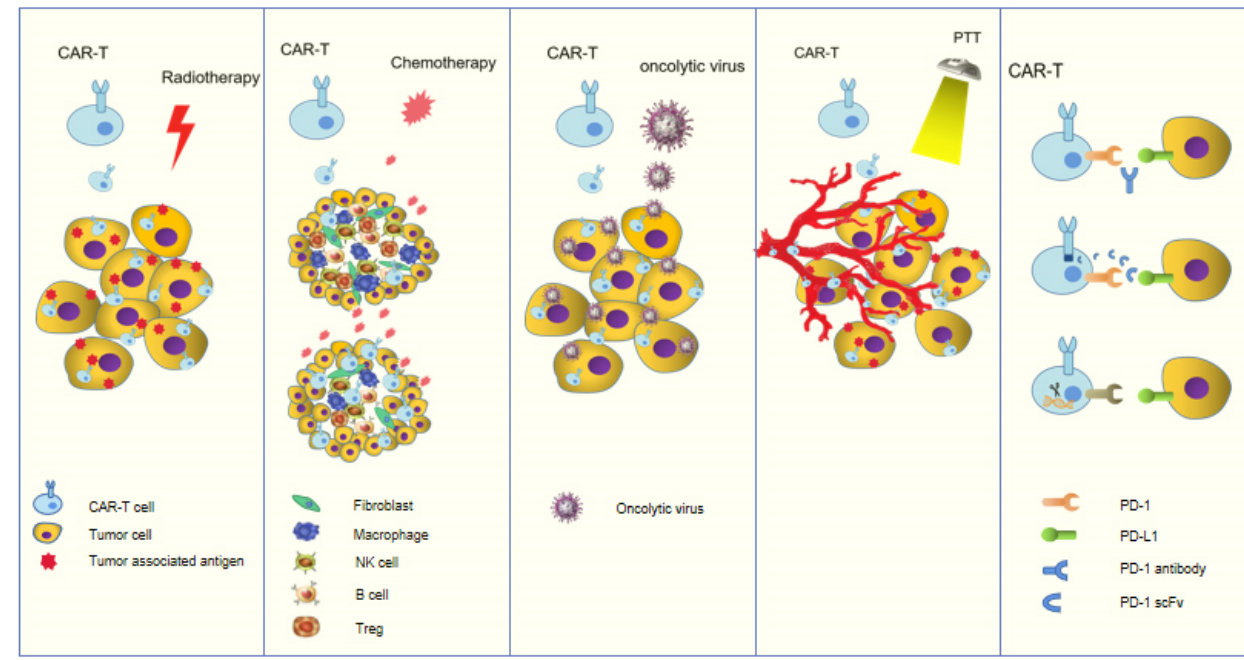
Figure 2. Several forms of CAR-T combination therapy.